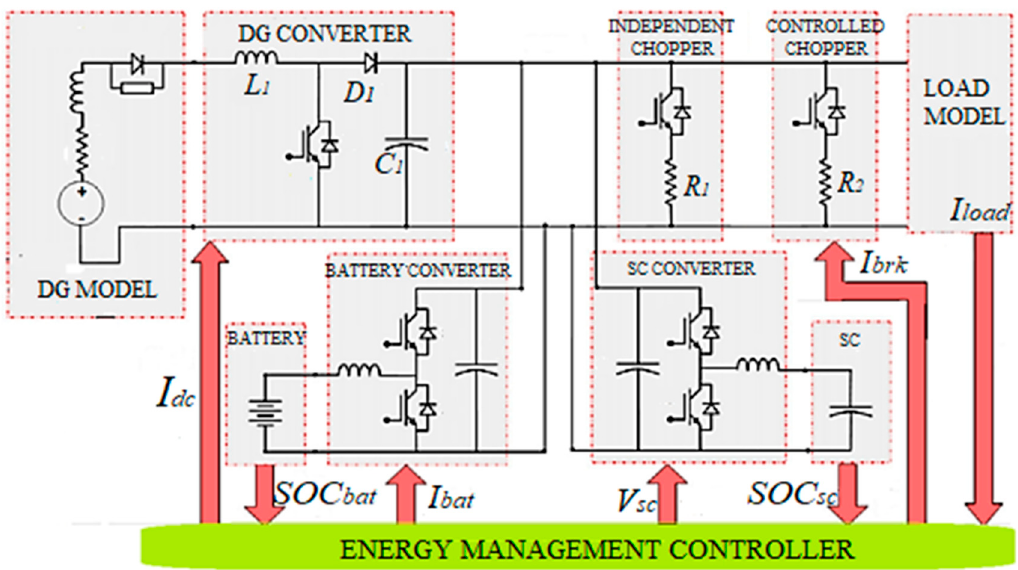
Figure 3. Configuration of proposed hybrid RTGC model. DG: diesel generator; SC: supercapacitor bank.